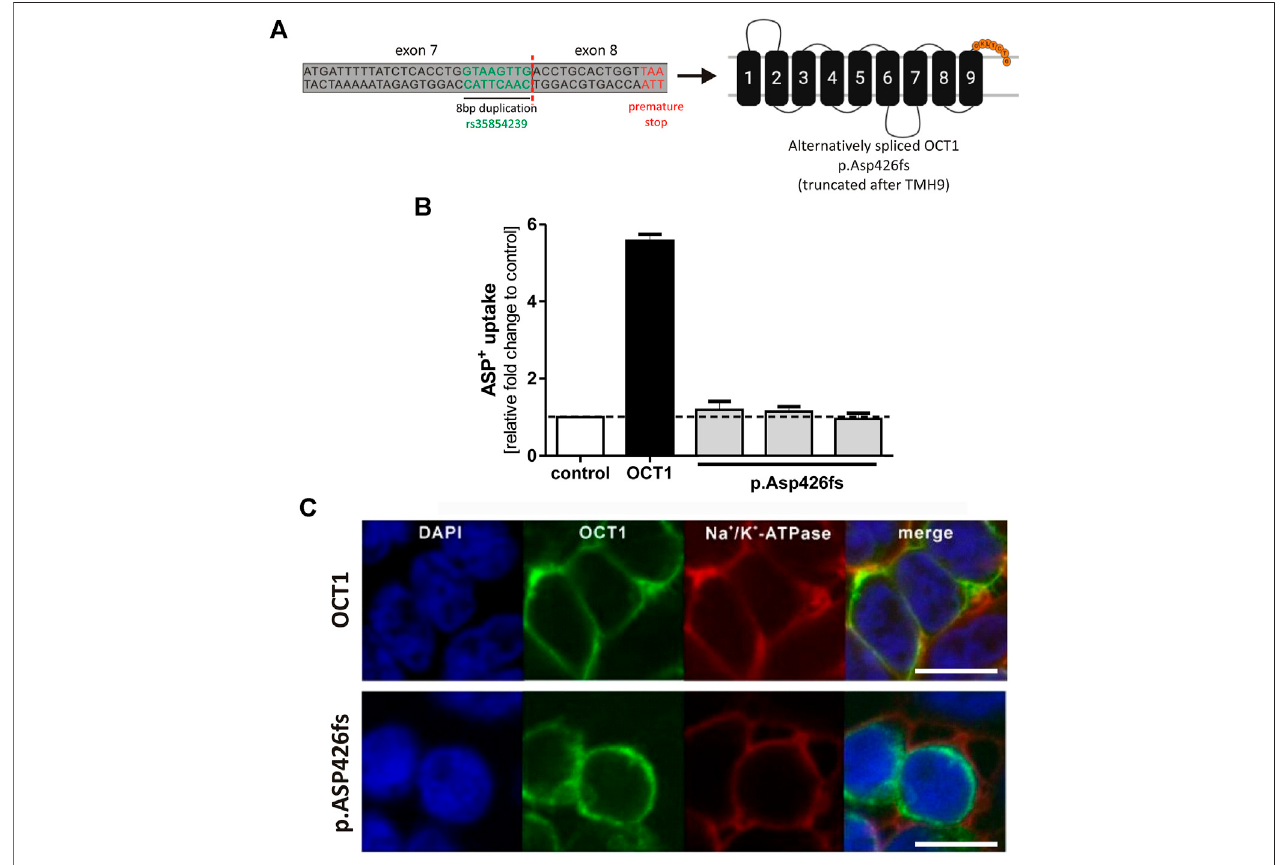
FIGURE 3 | Effects of the alternatively spliced OCT1 protein p.Asp426fs on OCT1 function (A) Alternative splicing of rs35854239 leads to a premature stop after Asn431, resulting in an OCT1 protein that is truncated after transmembrane helix 9. (B) HEK293 cells transiently transfected with a vector coding for the alternatively splicedOCT1p.Asp426fswereincubatedfor2 minwith20 μ MASP + .TheOCT1-mediateduptakewascalculatedasfoldchangecomparedtocontrolcells(transfected with the empty vector). Transfection of wild-type OCT1 served as a positive control for functional transporter. Data are shown as mean and standard error of the mean (SEM) of three independent experiments. (C) Membrane localization was analyzed using immuno fl uorescence staining and confocal microscopy (magni fi cation factor 63). The OCT1 antibody used for this purpose recognizes the intracellular loop of the protein between TMH6 and TMH7. OCT1 (green) was co-stained with Na + / K + -ATPase (red) as membrane marker. Scale bar indicates 10 µm. TMH, transmembrane